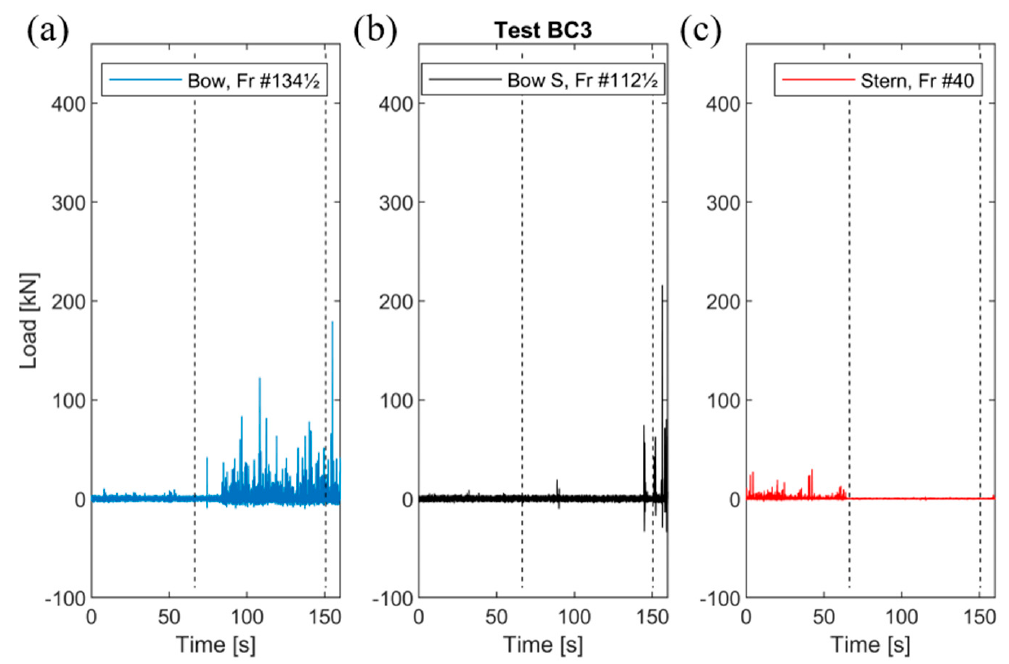
Figure A7. Measured ice-induced loads at ( a ) bow, ( b ) bow shoulder, and ( c ) stern shoulder during test BC3.